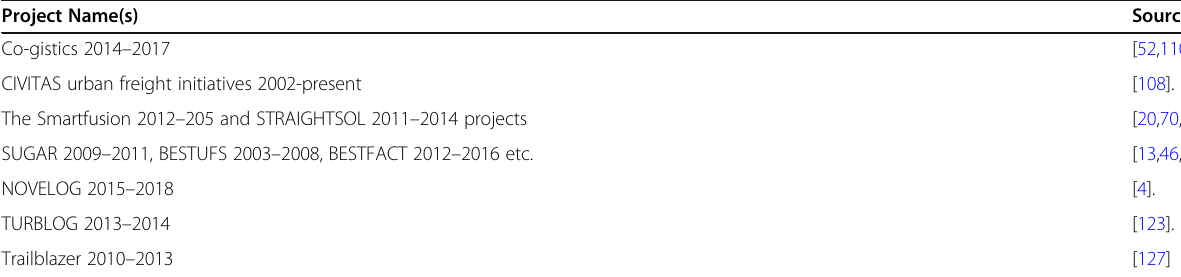
Table 2 Key Bibliographic Projects on Grey Literature Project